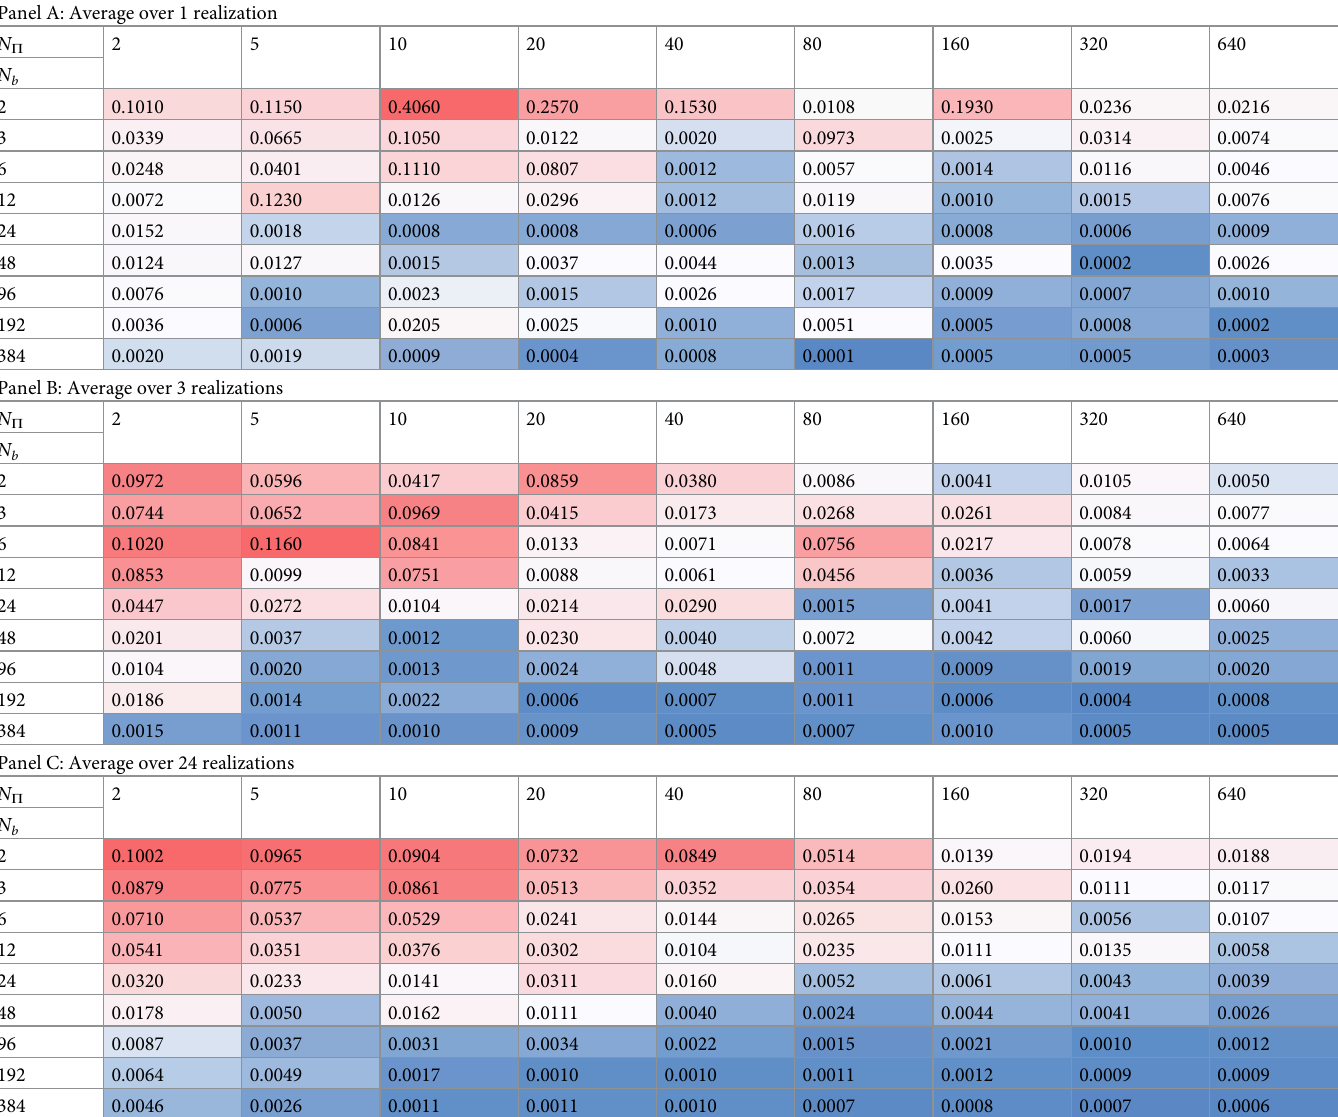
Table 1. Diffusivity equation—forward modeling: PINN performance as function of training set size. Relative L 2 errors between the exact and predicted values of p for the validation set. The table shows the dependency on the number of the initial and boundary training data, N b , and on the number of collocation points, N P . Here, the net- work architecture is fixed to 4 layers with 10 neurons per hidden